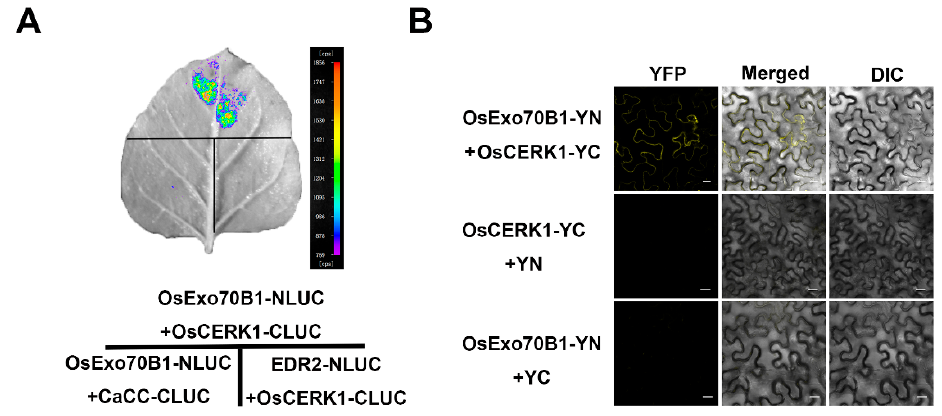
Figure 8. OsExo70B1 associates with OsCERK1. ( A ) The interaction between OsExo70B1 and OsCERK1 was examined with the split-luciferase complementation assay in N. benthamiana . Co-infiltrated of OsExo70B1 fused with N-terminus of the Renilla luciferase fragment and OsCERK1 fused with the C-terminus of the Renilla luciferase fragment in N. benthamiana leaves by agrobacterium tumefaciens strain GV3101 mediated transformation. At the second day after injection, the infiltrated leaves were sprayed with 1 mM luciferin and the fluorescence signal was captured by a cooled charge coupled device (CCD) camera. The combinations of OsExo70B1 -CaCC and OsCERK1-EDR2 were used as the controls. ( B ) The interaction between OsExo70B1 and OsCERK1 was examined with the BiFC assay in N. benthamiana . OsExo70B1 and OsCERK1 were fused to the N-terminus of the yellow fluorescent protein (YFP) fragment (YN) or the C-terminus of the YFP fragment (YC), respectively, and agrobacterium tumefaciens strain GV3101 containing the indicated construct pairs were co-infiltrated into N. benthamiana leaves. YFP fluorescence was detected by confocal microscopy. Bar = 20 μ m.